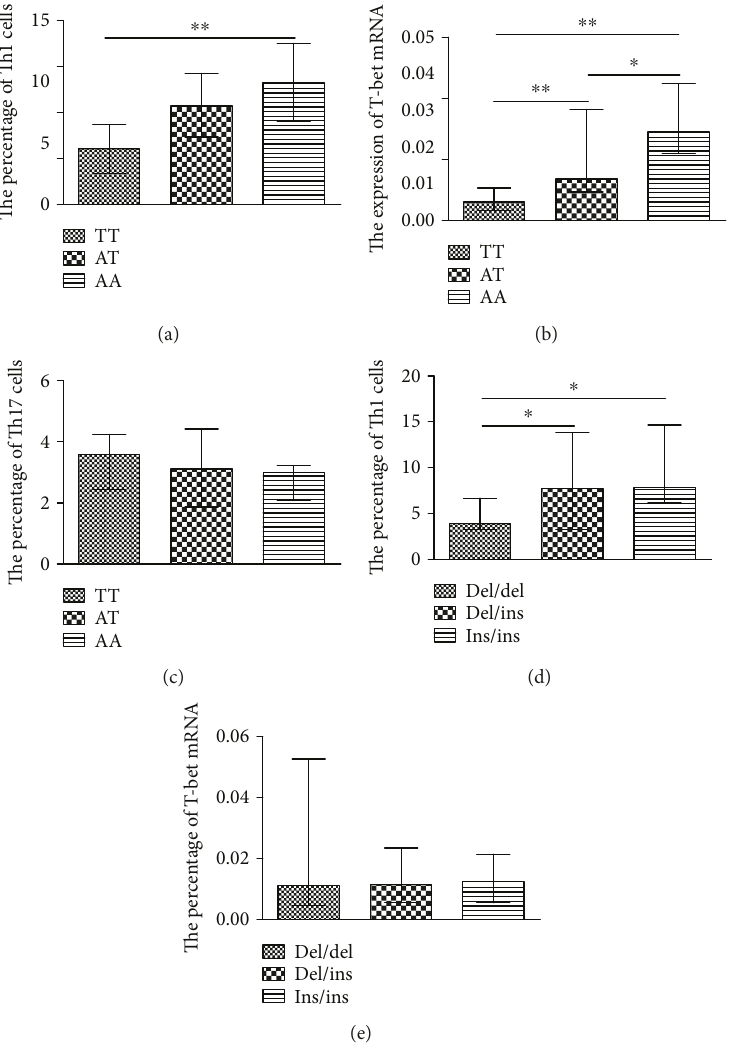
Figure 5: The genotypes of gene polymorphisms may be associated with the T helper subsets in PBMCs of MM patients. (a) The percentage of Th1 cells in TT, AT, and AA in rs2043211 of CARD8. (b) The relative expression of T-bet mRNA in TT, AT, and AA of rs2043211 of CARD8. (c) The percentage of Th17 in the genotypes of rs2043211. (d) The percentage of Th1 cells in del/del, del/ins, and ins/ins of NF- κ B, respectively. (e) The association between the relative mRNA expression of T-bet and the genotypes of NF- κ B. ∗ P < 0 05 and ∗∗ P < 0 01